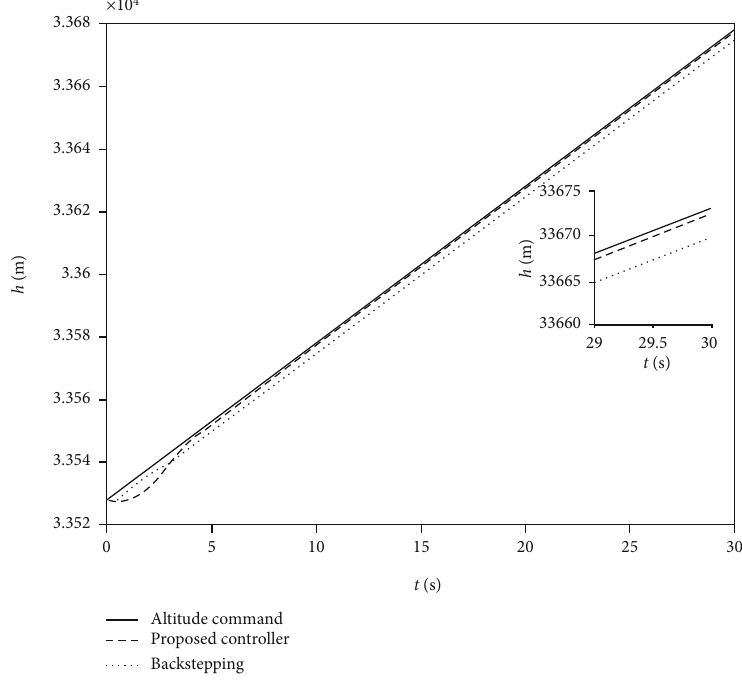
Figure 3: Altitude